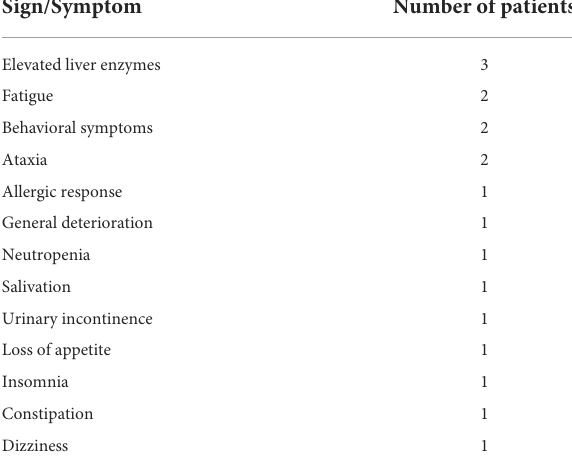
TABLE 2 Prevalence of adverse events in 75 patients treated with felbamate. Sign/Symptom Number of